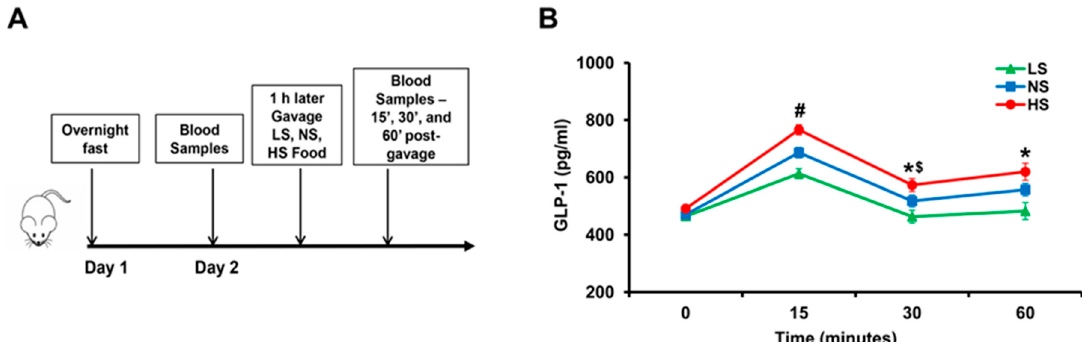
Figure 1. The effect of varying amounts of sodium in the diet on serum GLP-1 levels in BALB/c mice. ( A ) After an overnight fast, on the morning of day 2, 120 µ L of blood samples were drawn from the caudal vein. One hour later, the mice were gavaged with 1 mL of low salt (LS), normal salt (NS), or high salt (HS) food which contained <0.04 mmol sodium, 0.56 mmol sodium, and 0.84 mmol sodium/0.1 kg body weight, respectively. Then 120 µ L of blood were drawn at 15’, 30’, 60’ post gavage. ( B ) Serum GLP-1 in BABL/c mice at different time points after gavage. # p < 0.05 vs. NS or LS at 15’, * p < 0.05 vs. LS at 30’ and 60’, $ p < 0.05 vs. HS at 15’ or 60’. One-way ANOVA, Holm–Sidak test, n = 3–6/group.